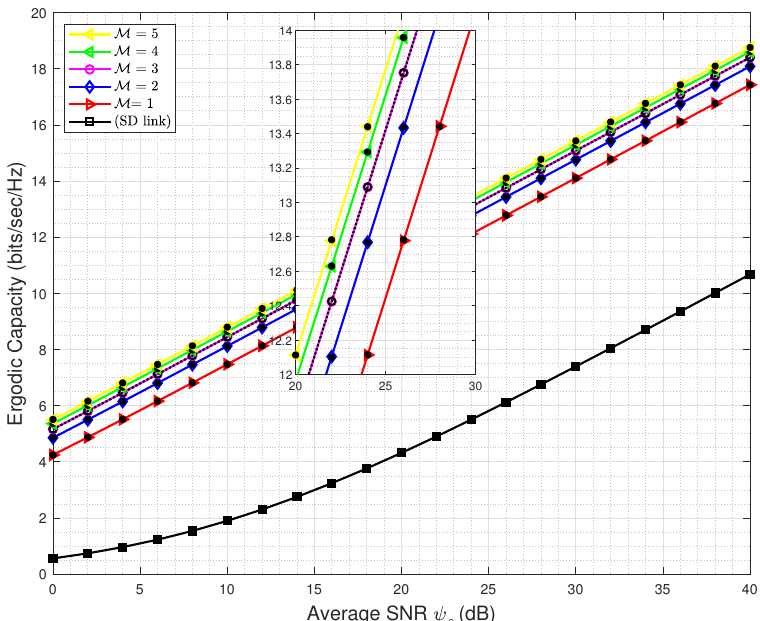
Figure 5. Ergodic capacity ( C e ) versus average SNR ( ψ ◦ ) db. M and SD represent number of relays and direct non-relayed links from source to destination,